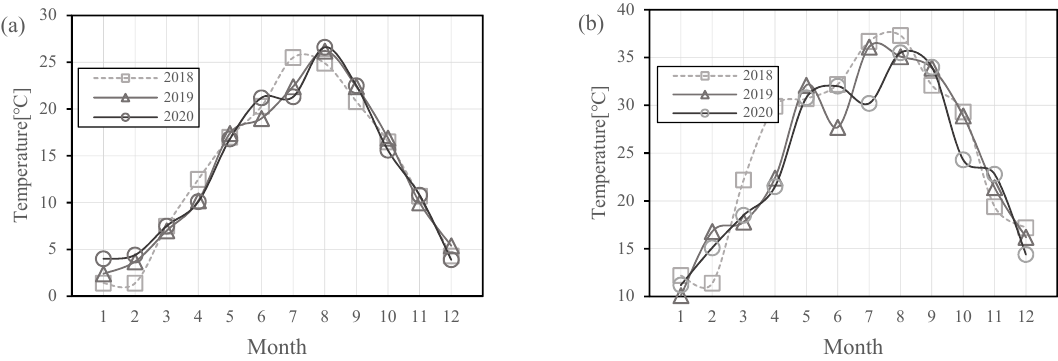
Figure 5. ( a ) Monthly average temperature from 2018 to 2020; ( b ) monthly maximum temperature from 2018 to 2020.